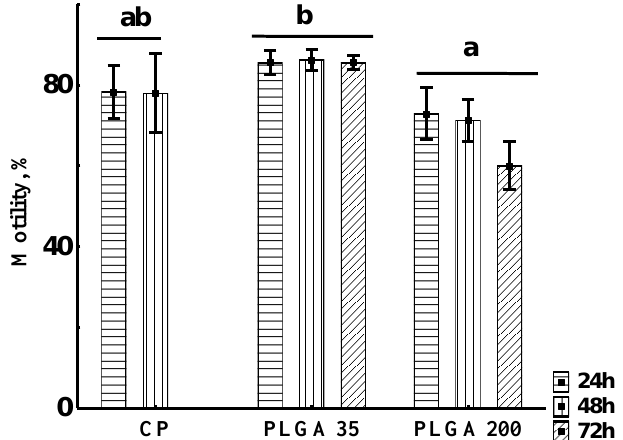
Figure 8. Sperm motility percentage (Motility, 10 s post-activation) of sterlet sperm samples obtained after hormonal treatments at different post-injection times (24, 48, and 72 h). Horizontal Lines indicate no significant f factor “ post-injection time ” (two-way ANOVA, p = 0.989). Different letters indicate significant differences among treatments by different hormones, combined by the factor “ post-injection time ” (two-way ANOVA, p < 0.001; Tukey ’ s post-hoc test, p < 0.05). Experimental treatments: CP — carp pituitary extract, dose 4 mg/kg; PLGA35 — Alarelin, dose 35 µg/kg; PLGA200 — Alarelin, dose 200 µg/kg.